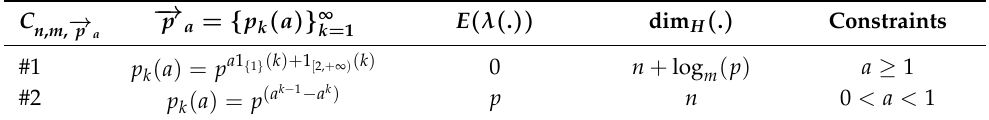
Table 1. Two sets with cardinality of continuum of random fractals in R n ( n ≥ 1 ) . C n , m , −→ p